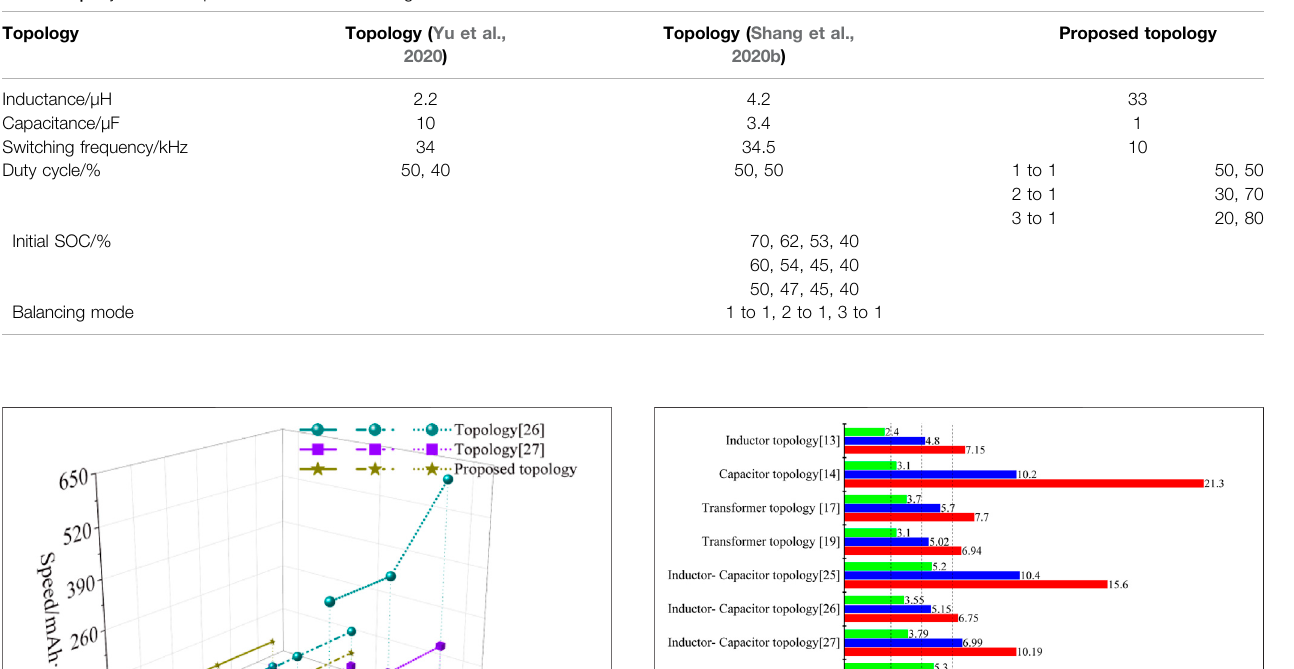
TABLE 3 | Key simulation parameters of the balancing model.